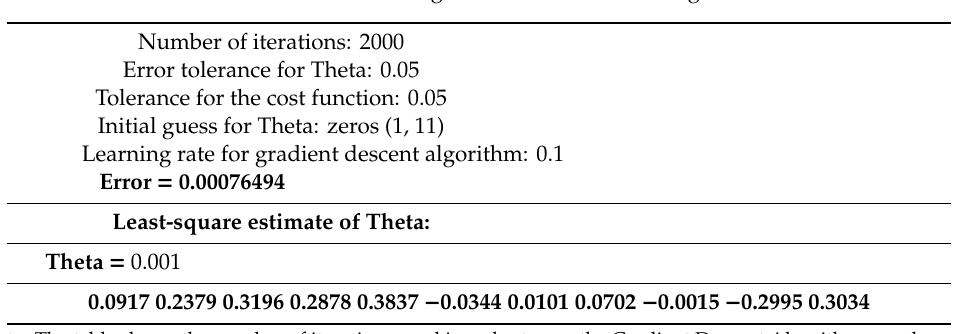
Table 6. Results involving the Gradient Descent